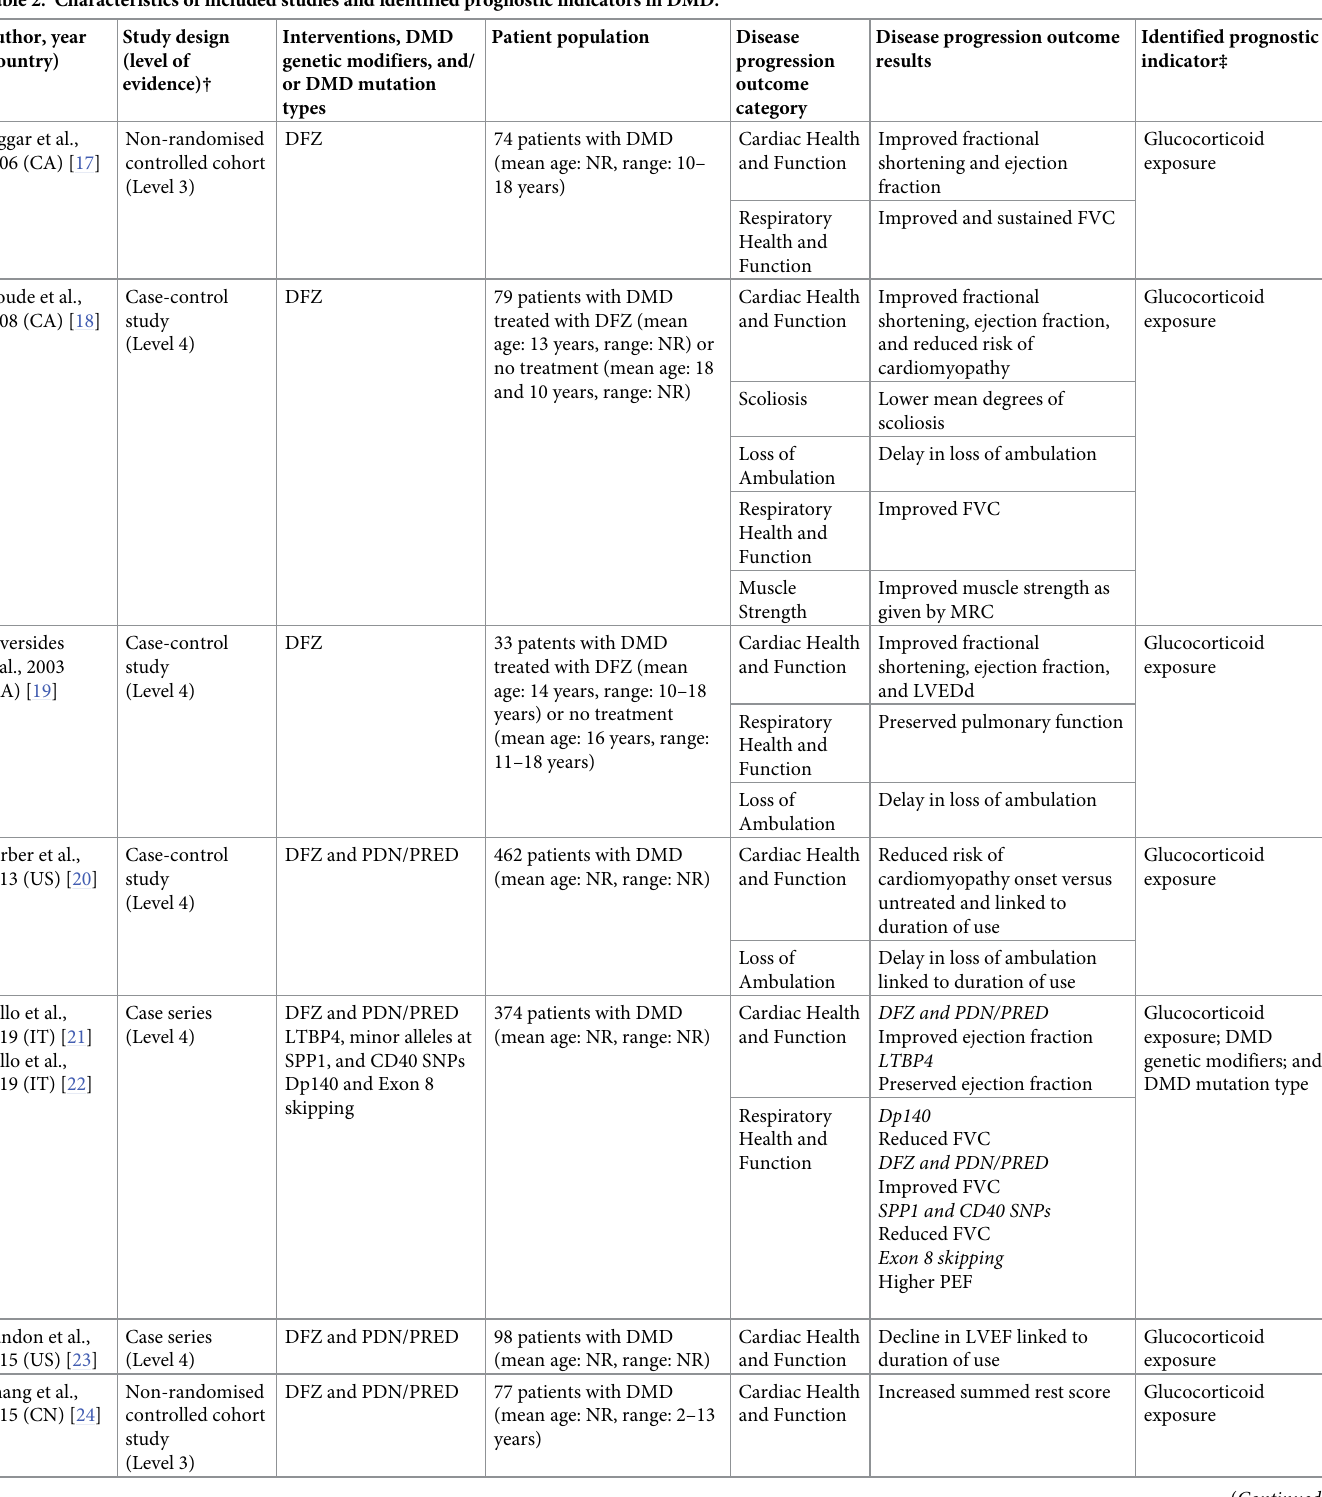
Table 2. Characteristics of included studies and identified prognostic indicators in